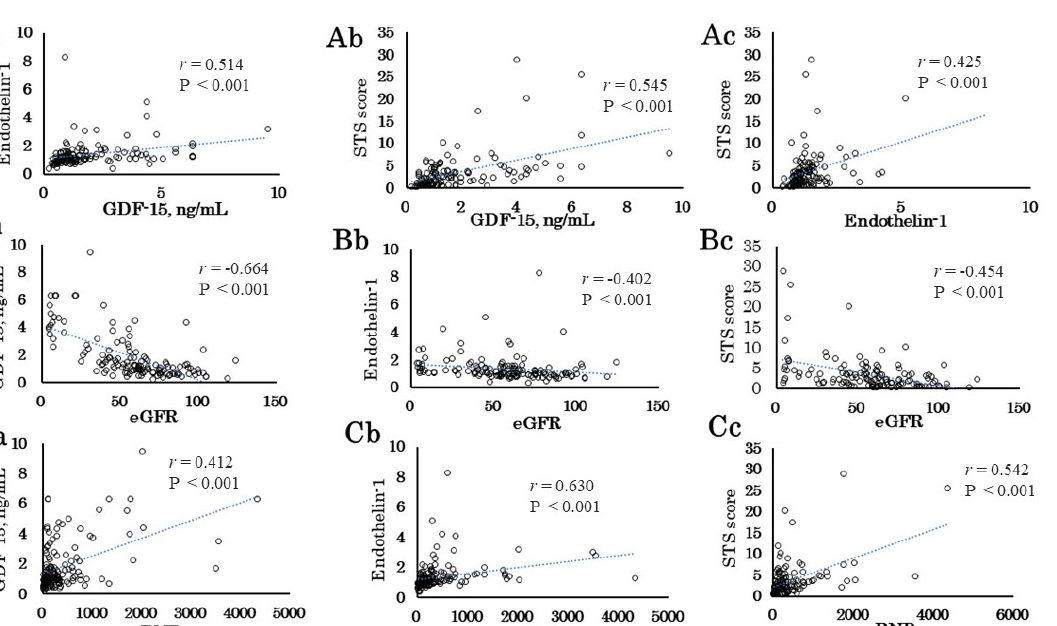
Table 3. Relationships between GDF-15/ET-1/STS score and operative data.